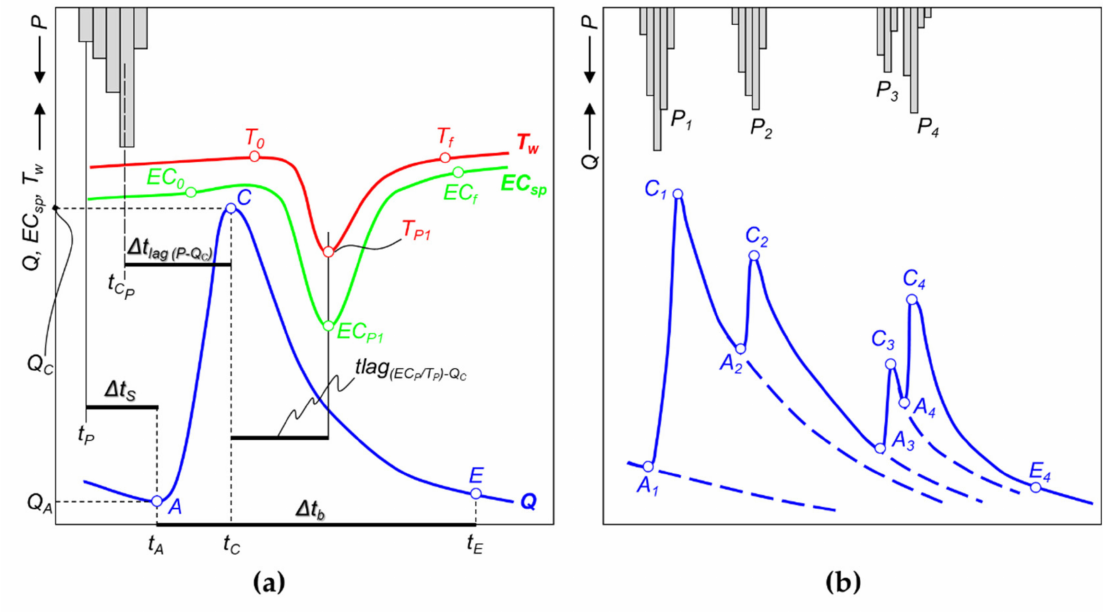
Figure 3. ( a ) Simple storm HTC-graph and its components: hydrograph ( Q ), thermograph ( T w ), and